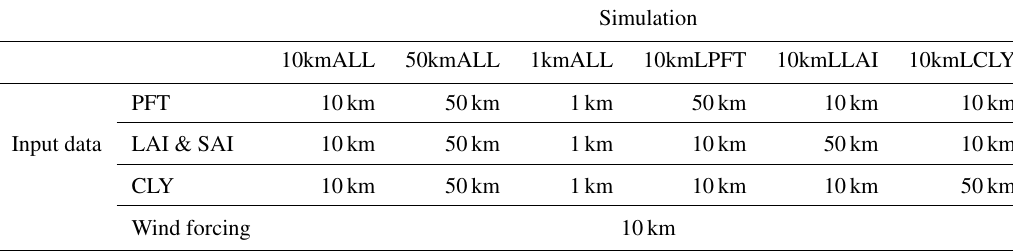
Table 3. Spatial resolution of input datasets used in